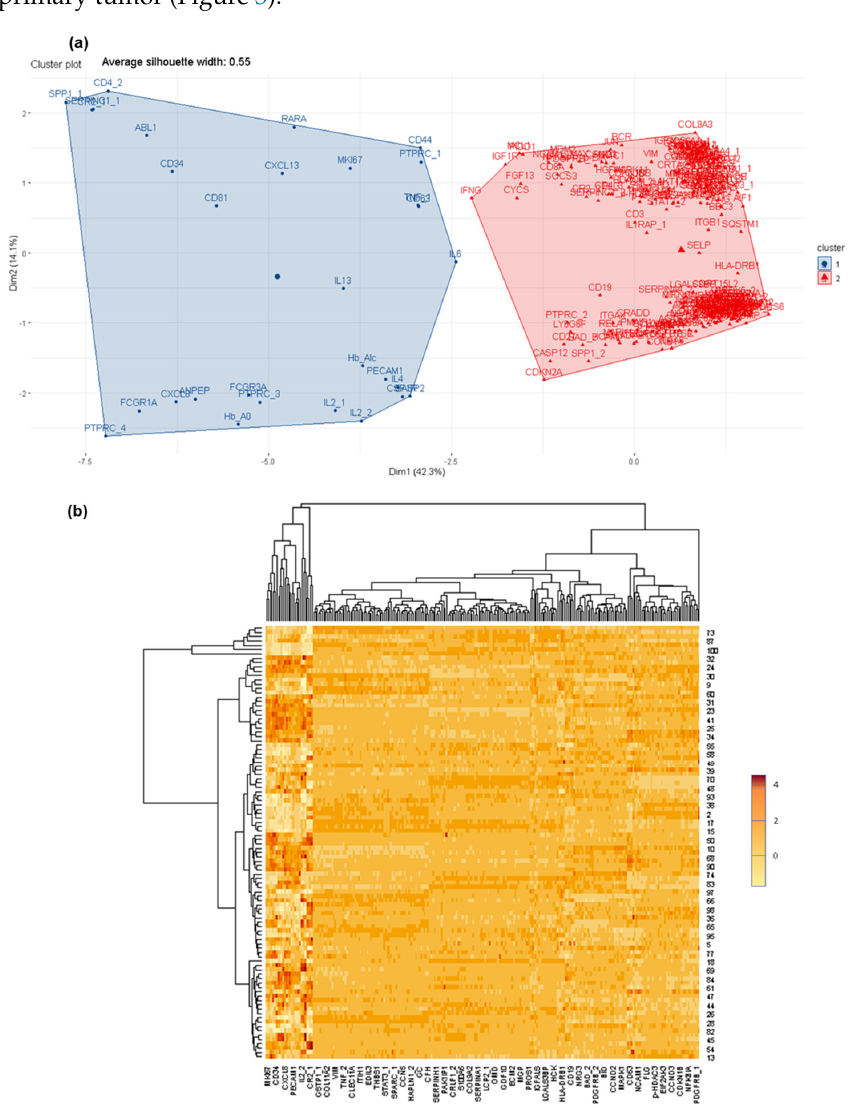
Figure 3. Differential protein profiles within CSF + LM according to the primary tumor (lymphoma and leukemia). ( a ) Differential protein profiles clustered to discriminate between CSF + LM (lym- phoma in contrast leukemia). ( b ) Heat map of protein distribution identified in this comparison.